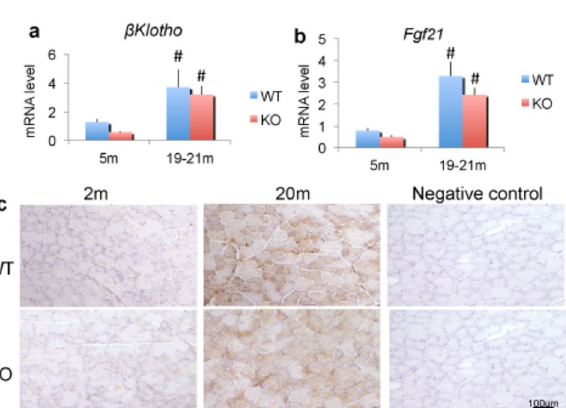
Figure 6. Expression of mRNA for adipocyte related genes and intramuscular fat accumulation in WT and Fgf2KO mice. Young (5 m) and old (20–24 m) WT and Fgf2 KO mouse hindlimb muscles were isolated and total RNA extracted from whole muscle for qPCR. ( a ) Plin1 mRNA was significantly increased in old WT and old Fgf2KO relative to young of both genotypes. ( b ) Pparg2 mRNA, ( c ) Adiponectin mRNA was significantly increased in old Fgf2KO relative to young Fgf2KO ( d ) Ap2 mRNA was significantly increased in old WT and old Fgf2KO compared with young of both genotypes . n = 4–8 mice/group. # Compared to corresponding 5 m p < 0.05. ( e ) AP2/GFP labeling is observed in young and old muscle of both genotypes but markedly increased staining is observed in muscle from old Fgf2KO mice compared with old WT. ( f ) Oil Red O staining showed markedly increased intramuscular fat tissue (arrows) in 20 m WT and 20 m Fgf2KO compared to 5 m- WT.